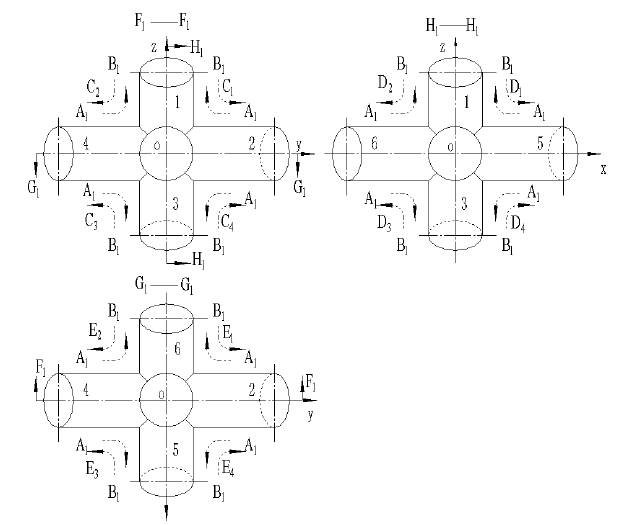
Fig. 14 Motion planning for ‘+’ space pipe.